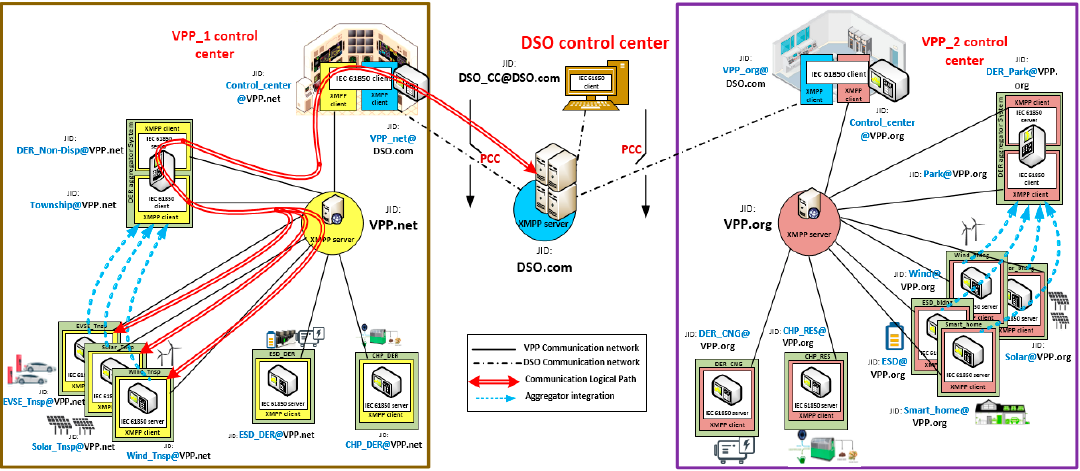
Figure 5. Organization of multiple domain XMPP based VPP with logical communication paths.